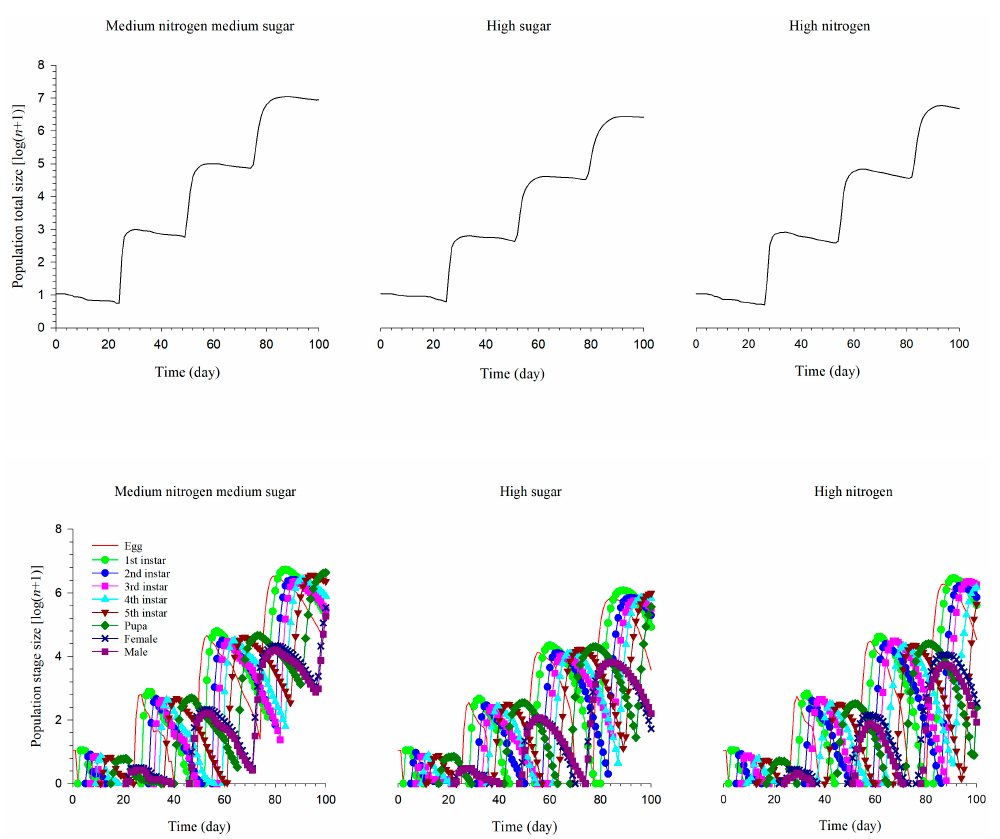
Figure 5. The prediction of S. exigua population size under different nutritional conditions.